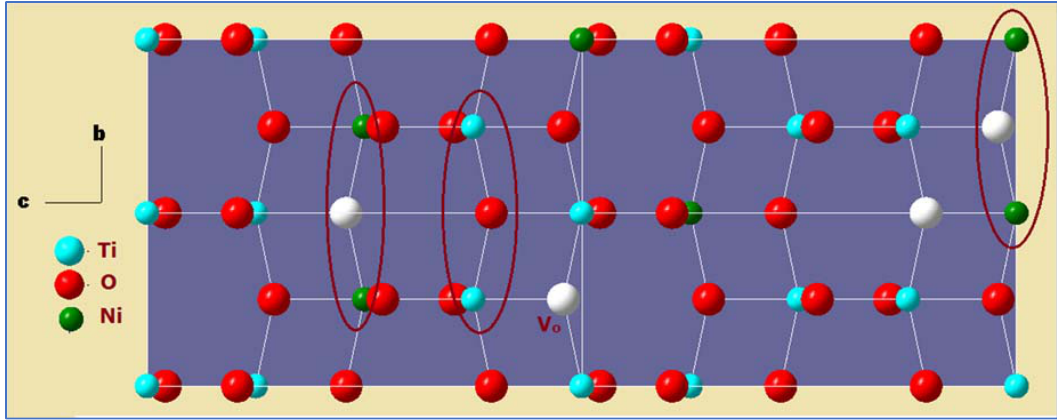
Figure 6. Bound magnetic polarons mechanism in Ni doped TiO 2 .